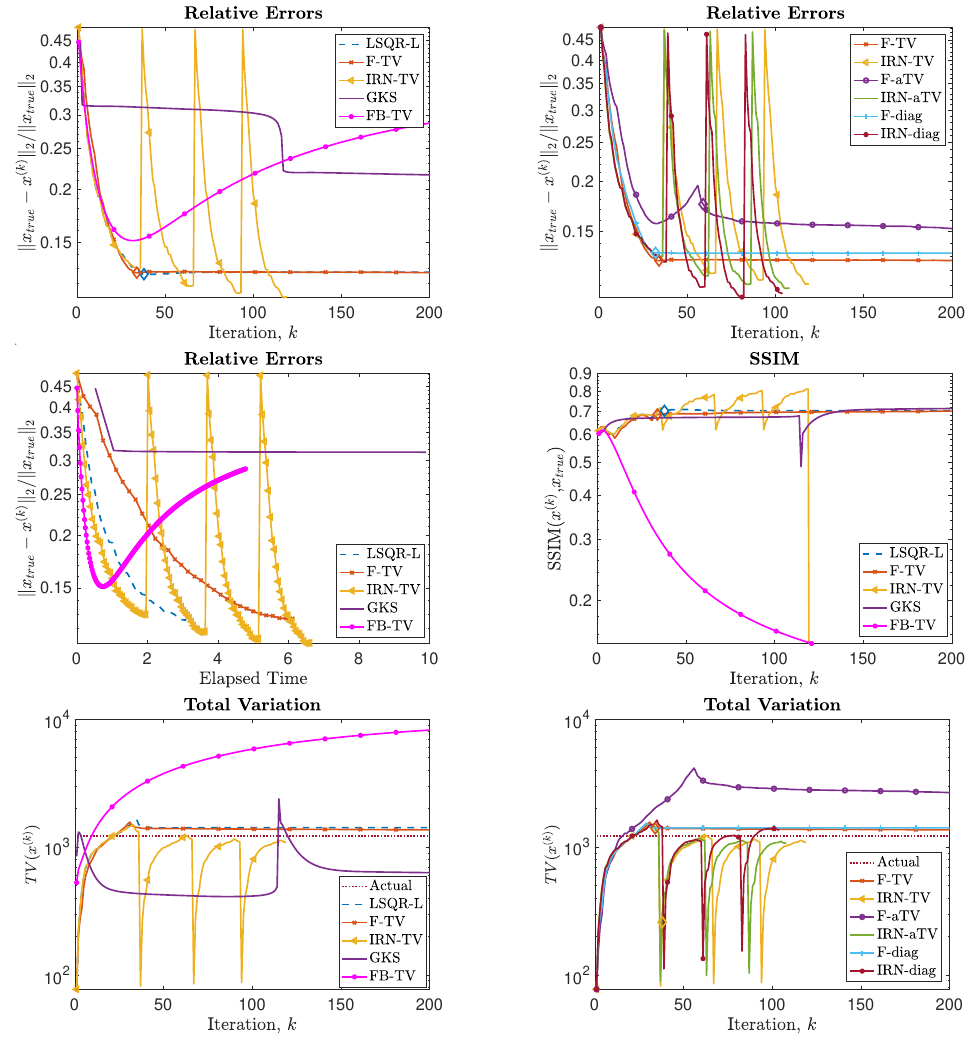
Figure 10. Experiment 3. ( Top row ): history of the relative error norms, comparing F-TV, F-aTV, F-diag, FBTV, and LSQR-L. Diamond markers indicate the iteration at which the stopping criterion (31) is satisfied. ( Second row , left ): progress of the F-TV, LSQR-L, FBTV, GKS and IRN-TV relative errors versus elapsed computational time. ( Second row , right ): SSIMs values versus iteration number for F-TV, LSQR-L, FBTV, GKS and IRN-TV. ( Bottom row ): history of the total variation of the reconstructions computed by each